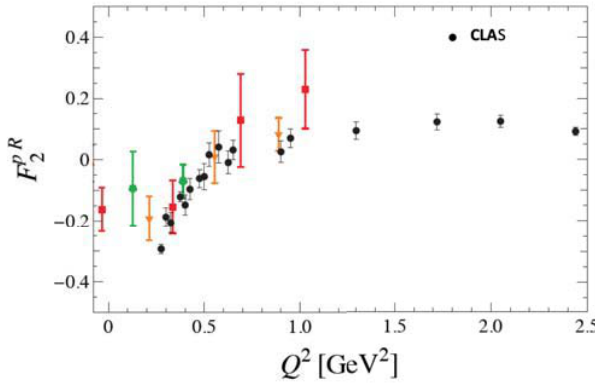
Fig. 16 The pN + (1440)1 / 2 + transition amplitude F 2 ( Q 2 ) from LQCD [62] compared to CLAS